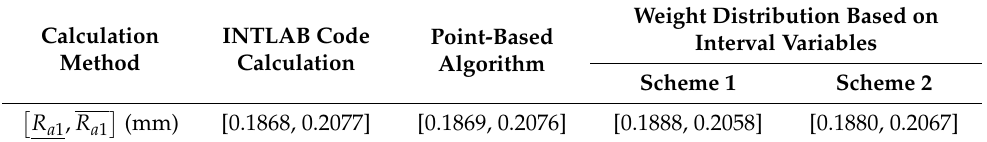
Table 6. Interval results of the permanent deformation of asphalt mixture with different calcula- tion